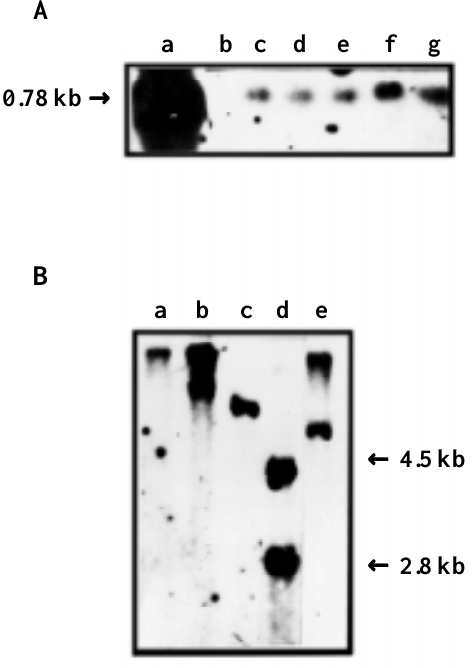
Figure 5 - Autoradiographs of Southern blots of genomic DNA extracted from G9-RNase -transformed tobacco plants and digested with restric- tion endonucleases. A , Bam HI, providing an RNase internal fragment; lanes a , plasmid positive control; b , nontransformed plant, negative con- trol, and c-g , transgenic clones RN1-5 , respectively; B , Xba I, providing T-DNA/plant DNA border fragments which reflect the number of T-DNA loci in each plant; lanes a-e , transgenic clones RN1-RN5 , respectively. The DNA fragment used as hybridization probe in the Southern blots is indicated as a black bar beneath the restriction enzyme map of the T- DNA region in Figure